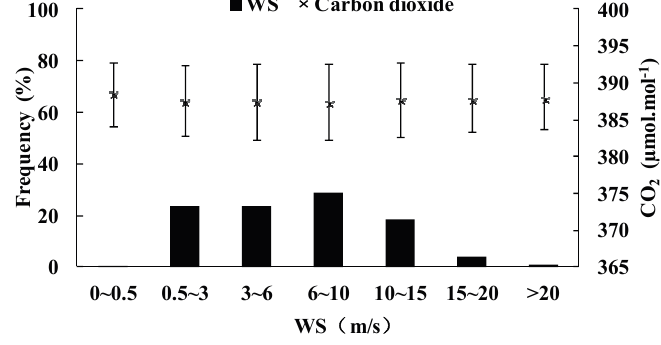
Figure 5. Frequency of occurrence of different wind speed scale and corresponding CO mole fraction (2010 through 2013). The black bars stand for frequency of occurrence. The vertical bars stand for the amplitude of CO wind speed